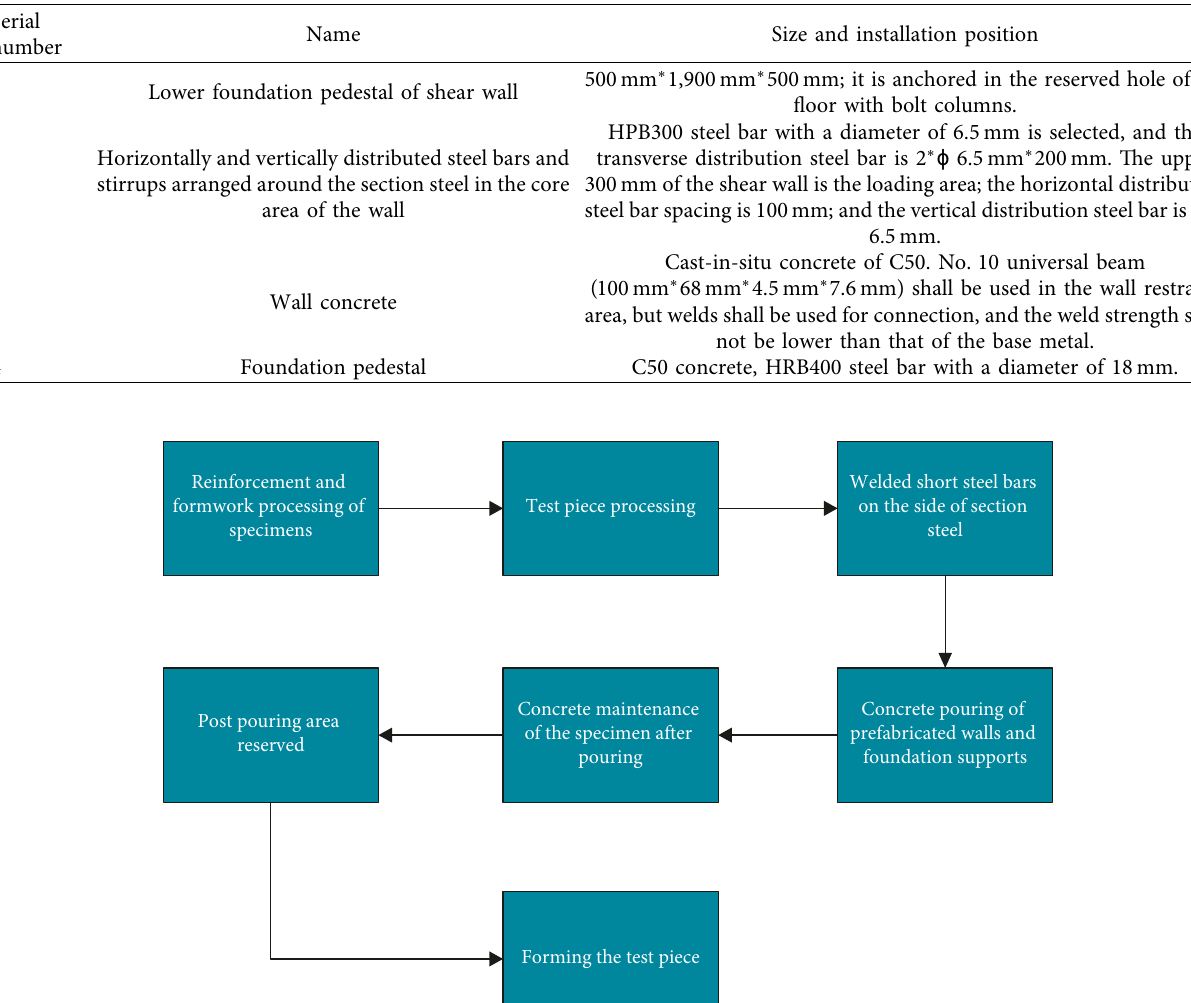
Table 2: Joint size and type.